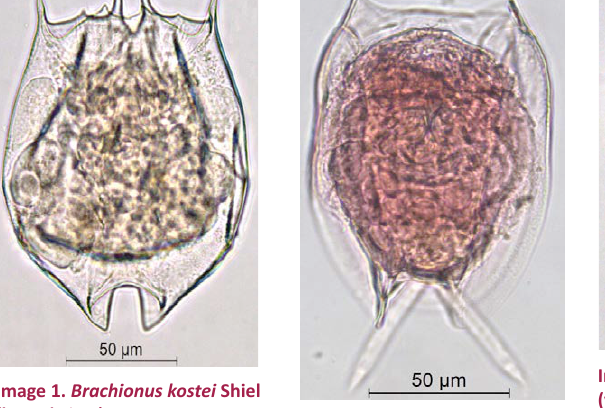
Image 2. Euchlanis meneta My- ers (dorsal view)